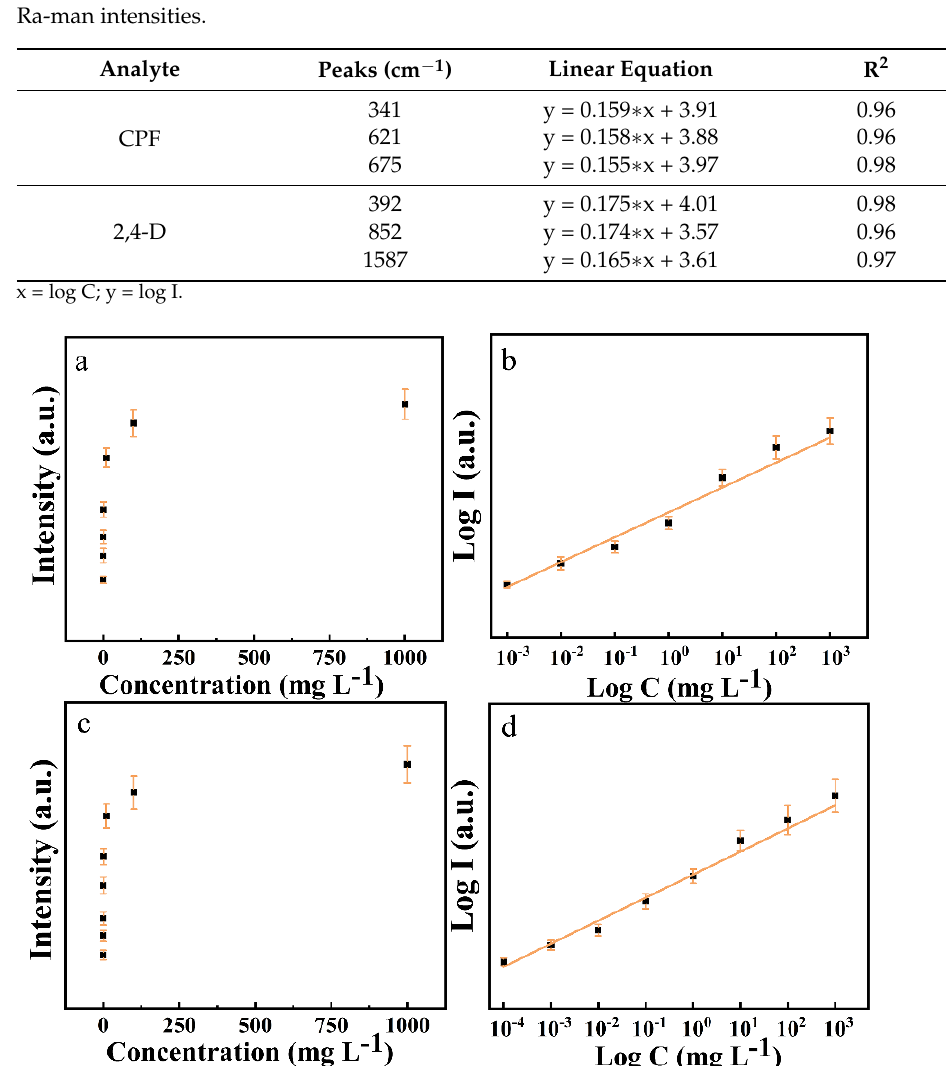
Figure 7. Linear relationship established of apple surface samples treated with ( a ) CPF and ( b ) 2.4 − D. Relationships of intensities of the SERS characteristic peak at 675 cm − 1 and concentrations of apple surface samples treated with CPF shown in linear coordinates ( a ) and log coordinates ( b ). Relationships of intensities of the SERS characteristic peak at 392 cm − 1 and concentrations of apple surface samples treated with 2.4 − D shown in linear coordinates ( c ) and log coordinates ( d ).